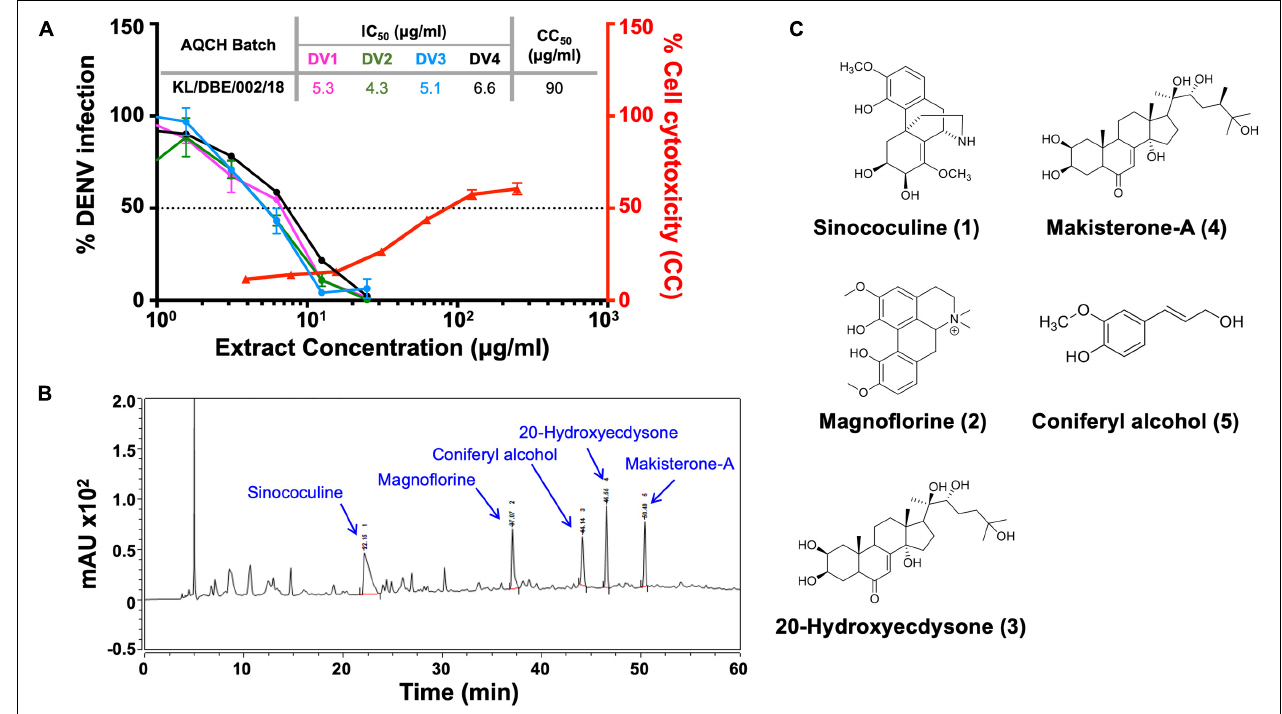
FIGURE 2 | Chemical fingerprinting of AQCH: (A) AQCH batch KL/DBE/002/18 was prepared, and its anti-dengue activity against DENV-1 (magenta curve), DENV-2 (green curve), DENV-3 (blue curve), and DENV-4 (black curve) was confirmed by flow-cytometry-based virus inhibition assay as represented by graph of % DENV infection on left y -axis and extract concentration. Extent of cell cytotoxicity caused by AQCH (represented by red curve) was also measured by MTT assay that is reflected on right y -axis of graph as % cell cytotoxicity for given extract concentrations on x -axis. CC 50 and IC 50 values corresponding to concentration of AQCH that is toxic for 50% of cells and at which 50% of DENV infection is inhibited as compared with virus control, respectively, has been represented by a dotted horizontal line; a table of IC 50 and CC 50 values has been provided as an inset. (B) High-performance liquid chromatography (HPLC) chemical fingerprinting profile of AQCH with peaks corresponding to five identified marker compounds annotated. (C) Chemical structure of five marker compounds